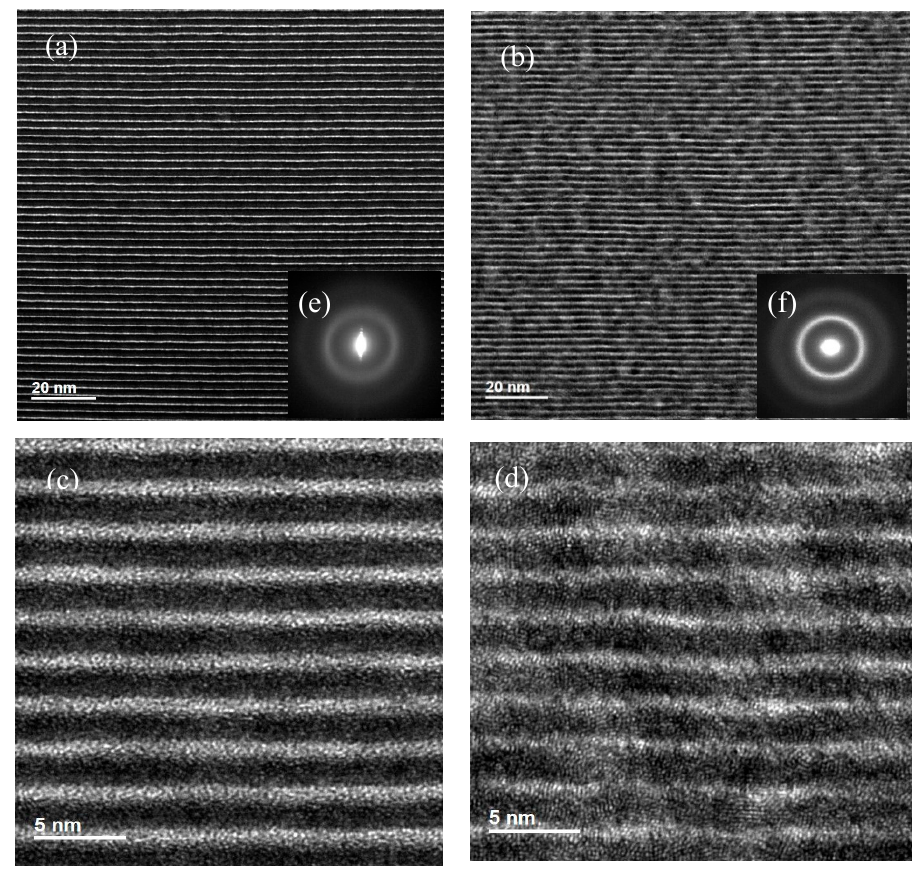
Figure 5. Transmission electron microscopy (TEM) and selected area electron diffraction (SAED) images of the 150-bilayer multilayers fabricated by Ar ( a , c , e ) and Kr ( b , d , f ).